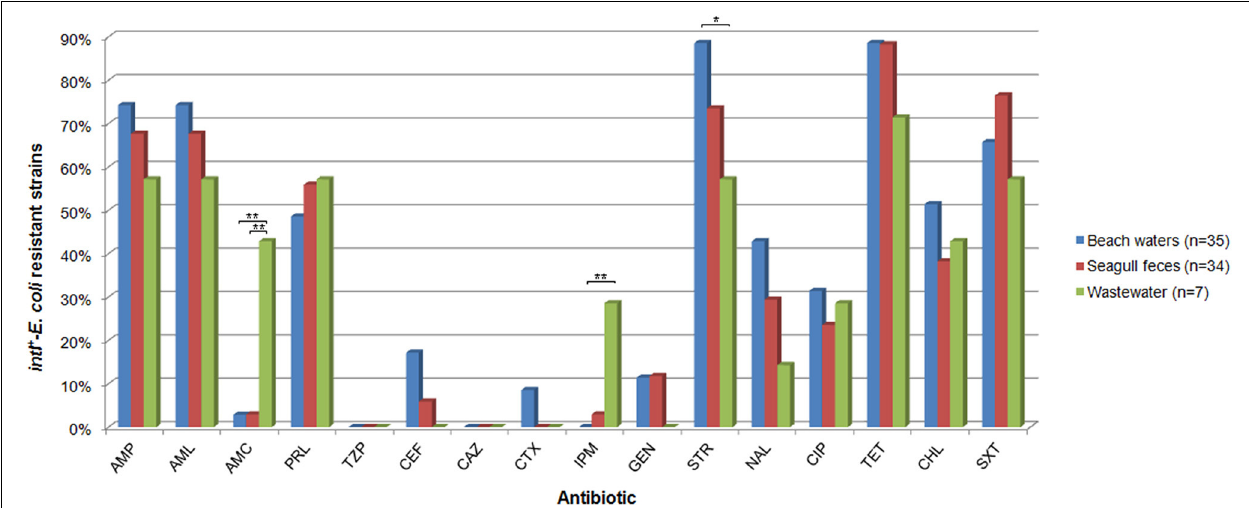
FIGURE 2 | Prevalence of antimicrobial resistance in intI + -E. coli strains. Antibiotic abbreviations: AMP, ampicillin; AML, amoxicillin; AMC, amoxicillin + clavulanic acid; PRL, piperacillin; TZP, piperacillin + tazobactam; CEF, cefalothin; CAZ, ceftazidime; CTX, cefotaxime; GEN,